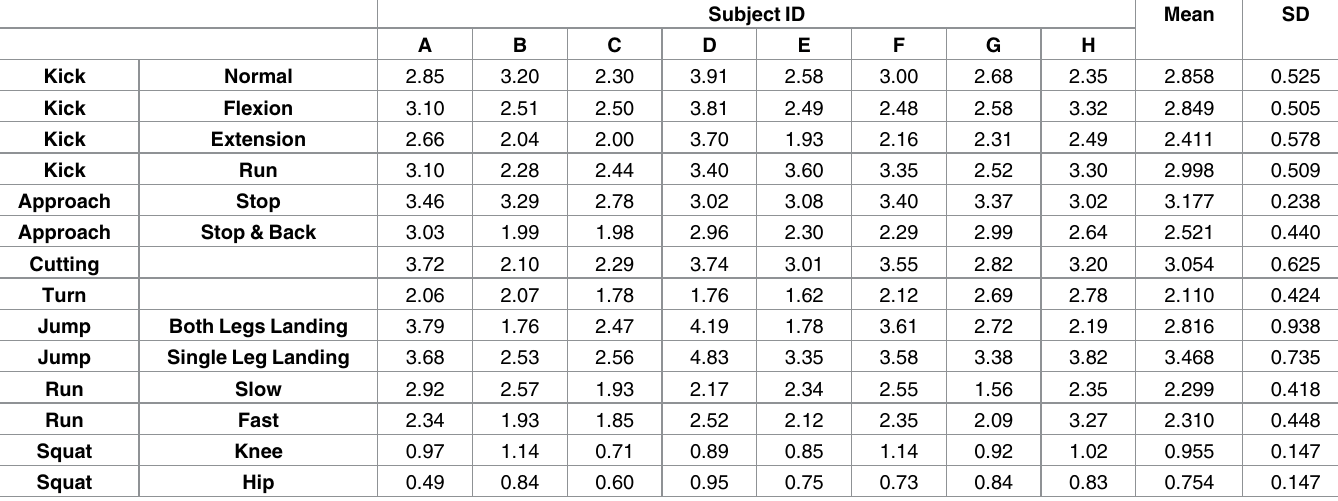
Fig 3 ranks the mean angular impulse of the knee extension moment greater than or equal to 1.5 Nm/kg in descending order. The motion with the highest mean angular impulse was "Cutting" (0.173 Nms/kg), followed by "Jump Single Leg Landing" (0.164 Nms/kg). The mean angular impulse for "Squat Knee" and "Squat Hip" were 0.000 Nms/kg and their knee extension Table 1. Peak knee extension moment per test subject for each motion